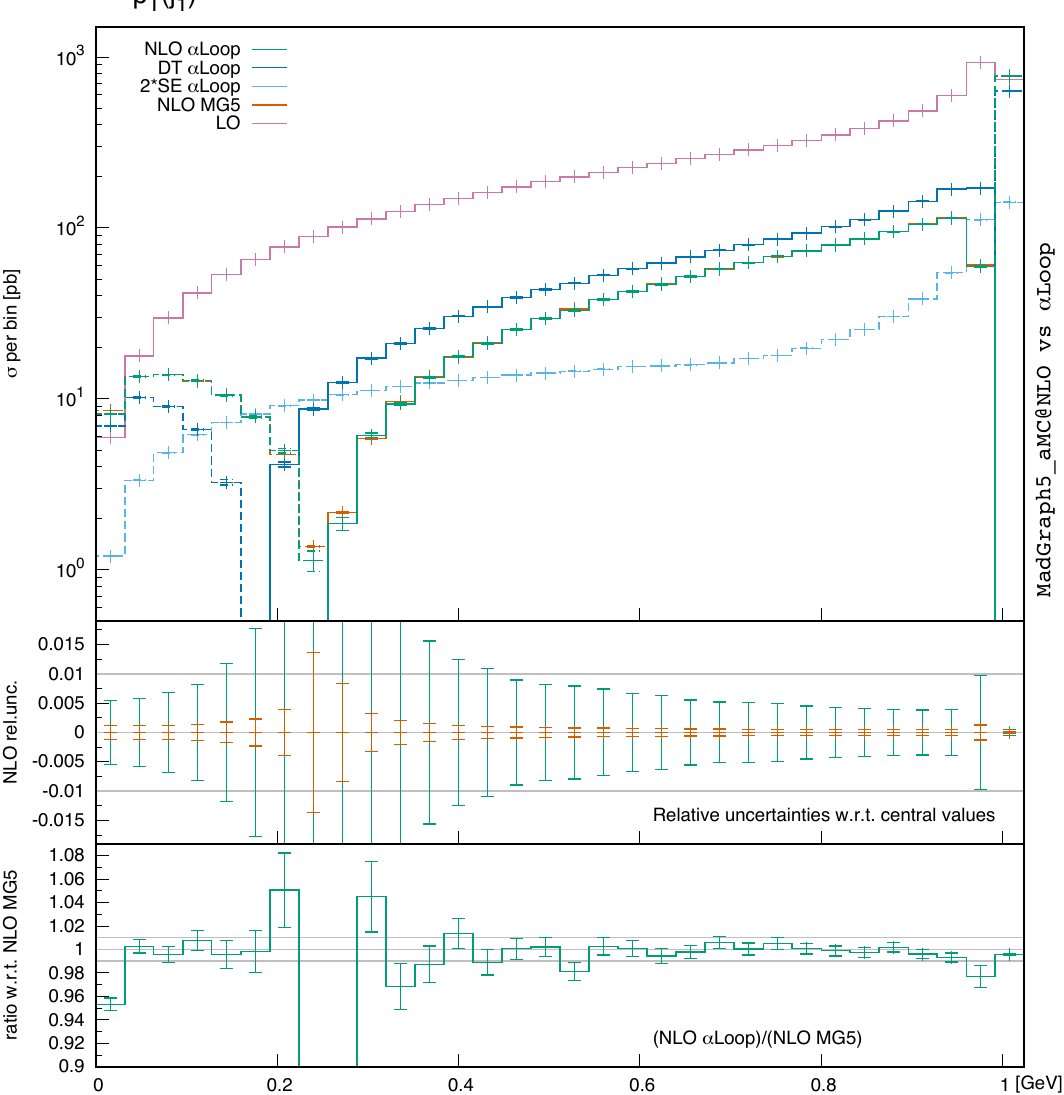
Figure 17. Comparison of the differential prediction for NLOQCD correction to the observable ¯ p t ( j 1 ) for the process e + e − → γ ? → d d as obtained from MadGraph5_aMC@NLO and α Loop . The Monte-Carlo sampling for this run with α Loop is 5 · 10 9 points. The dashed pattern indicates when a contribution is